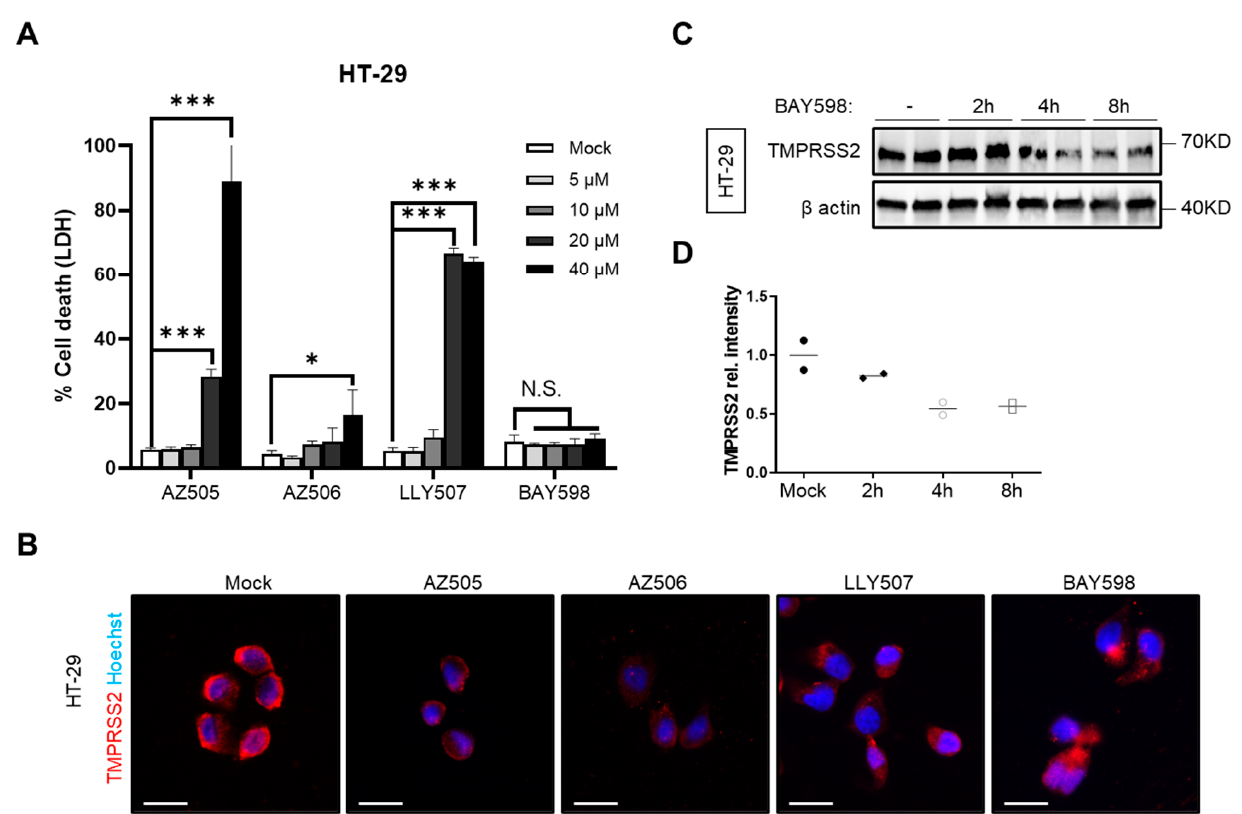
Figure 2. SMYD2 inhibition decreases TMPRSS2 expression in cultured HT-29 cells. ( A ) LDH release assay from HT-29 cells stimulated with increasing concentrations of AZ505, AZ506, LLY507, or BAY598 for 24 h. Experiments were performed two times and representative data of one experiment are shown. * p < 0.05 and *** p < 0.001. N.S., not significant. ( B ) Immunofluorescence staining